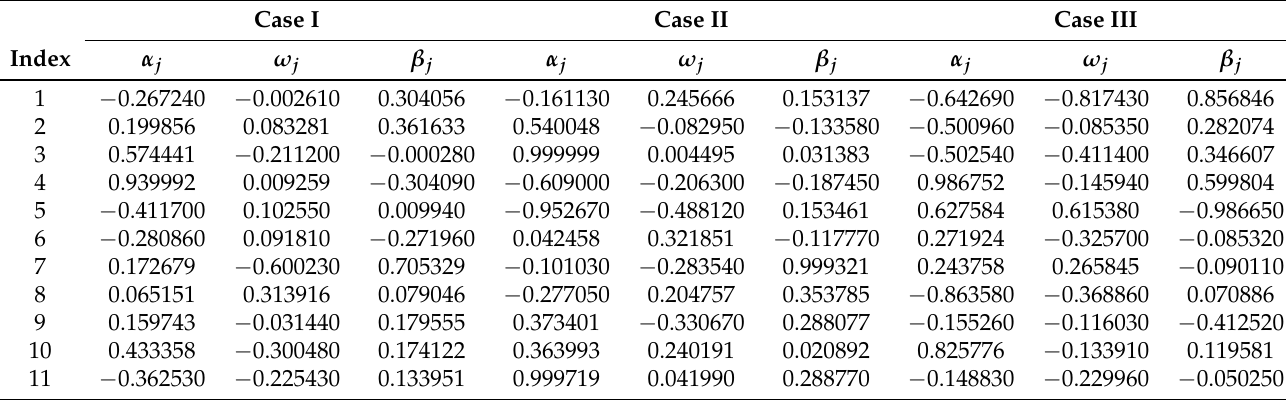
Table 7. Best set of weights obtained by the LNN-GNDO-SQP algorithm using a fitness function as in Equation (52). Here three cases are studied by varying S t in the drainage